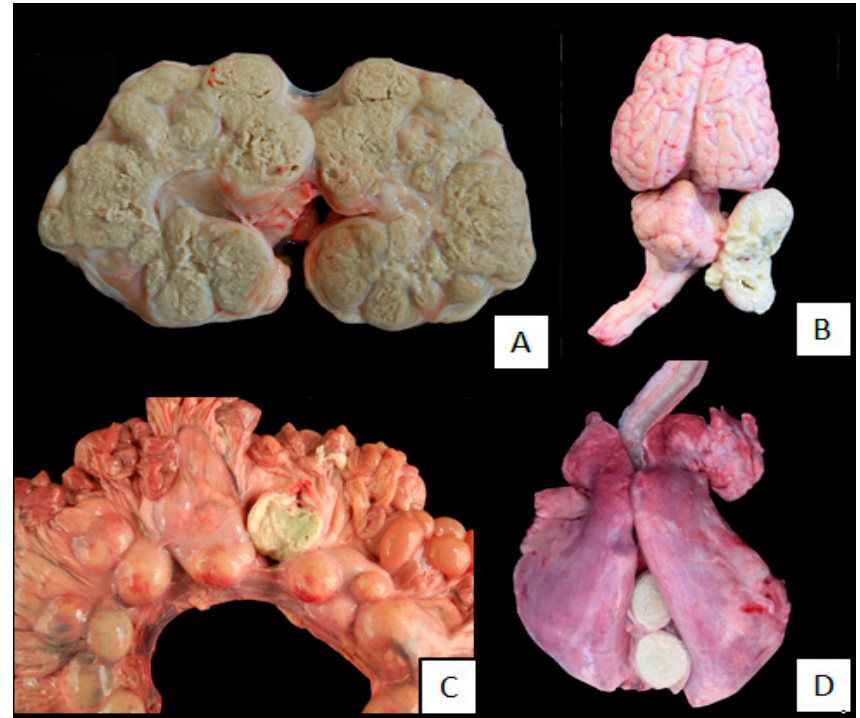
Figure 3. Pyogranulomatous lesions in internal organs of animals affected by caseous lymphadenitis (CLA) from which Corynebacterium pseudotuberculosis was isolated. ( A ). Pyogranulomatous lesions located in the kidney, almost affecting the whole parenchyma. ( B ). Pyogranulomatous lesion located next to the cerebellum. ( C ). Multiple pyogranulomatous lesions in the mesenteric lymph node, one of them opened to appreciate de caseous necrotic. ( D ). Pyogranulomatous lesion located in the mediastinal lymph node. The typical “onion ring” presentation is shown.